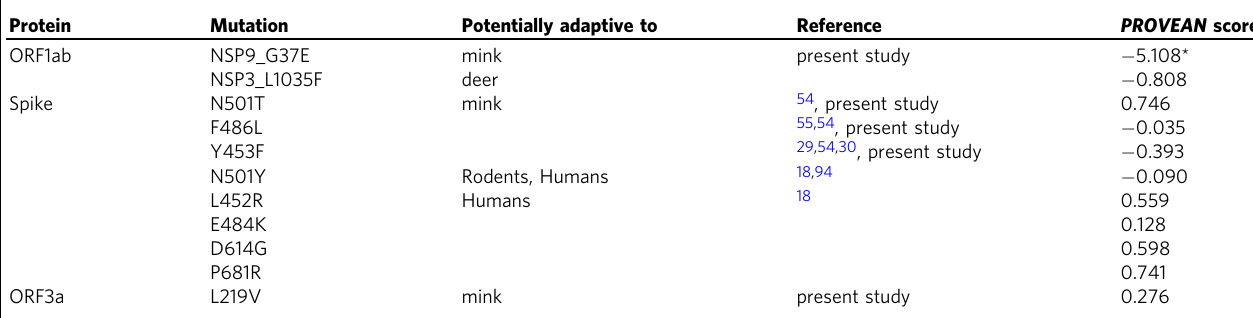
Table 2 PROVEAN scores of strong candidate mutations and other mutations previously described as adaptive to human and/or non-human hosts.